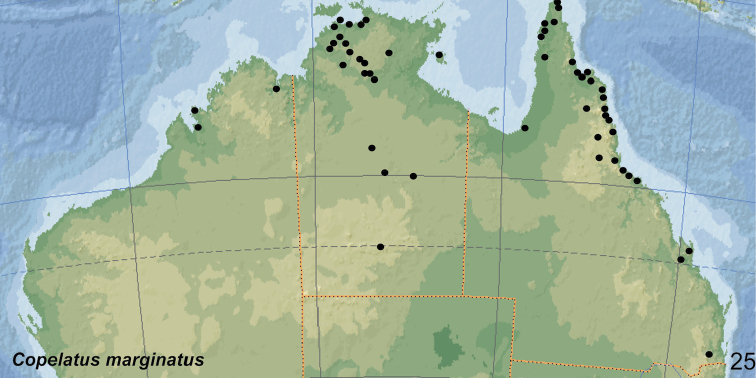
Distribution of Copelatus
marginatus.